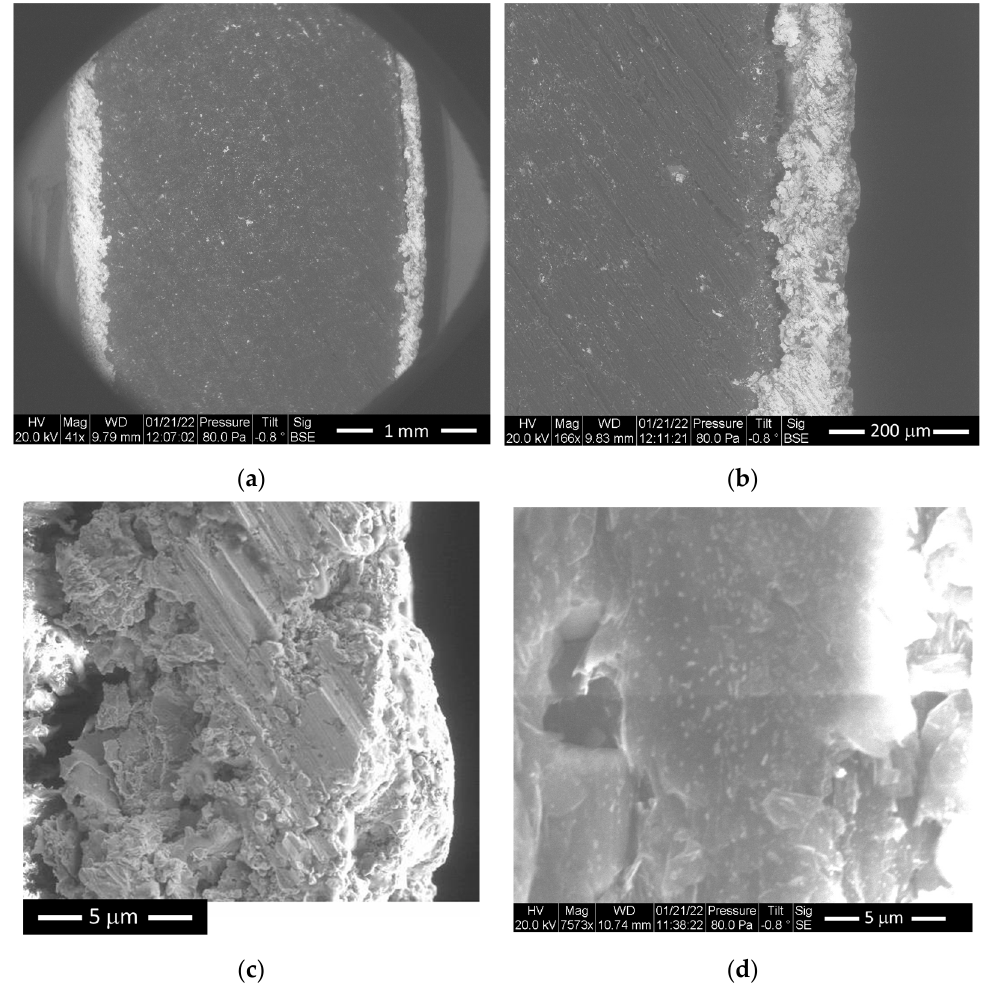
Figure 2. The ESEM of PPS with zinc coating: ( a ) backscattered (41 × ); ( b ) backscattered (166 × ); ( c ) zinc coating backscattered (862 × ); ( d ) PPS with 7573 × .